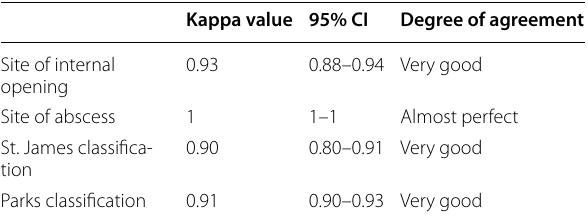
Table 9 Degree of agreement between MRI findings and